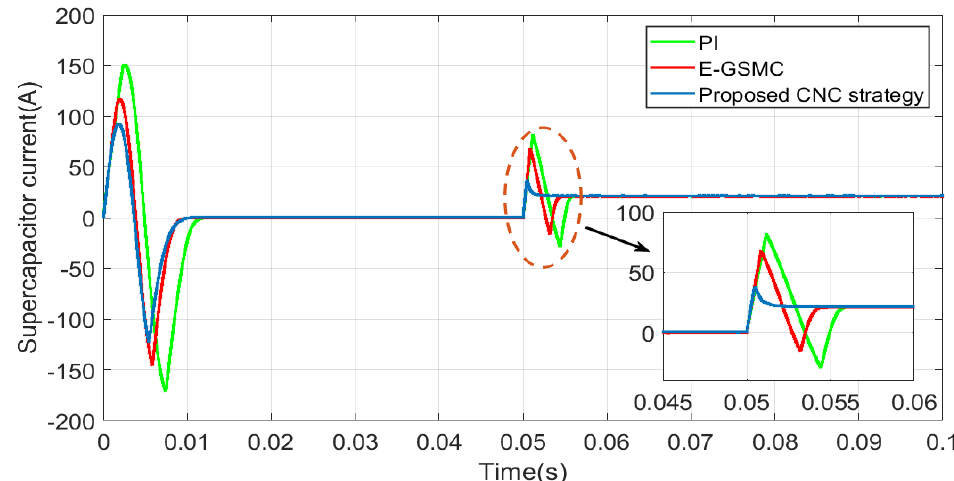
Figure 5. The dynamic response curve of the supercapacitor current.